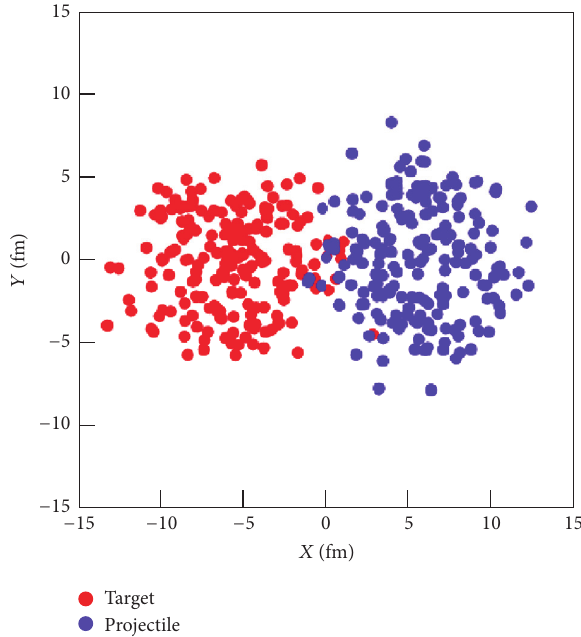
Figure 14: Distribution of nucleons inside target and projectile nuclei in a typical Au-Au collision at √𝑠 Figure is from [229].